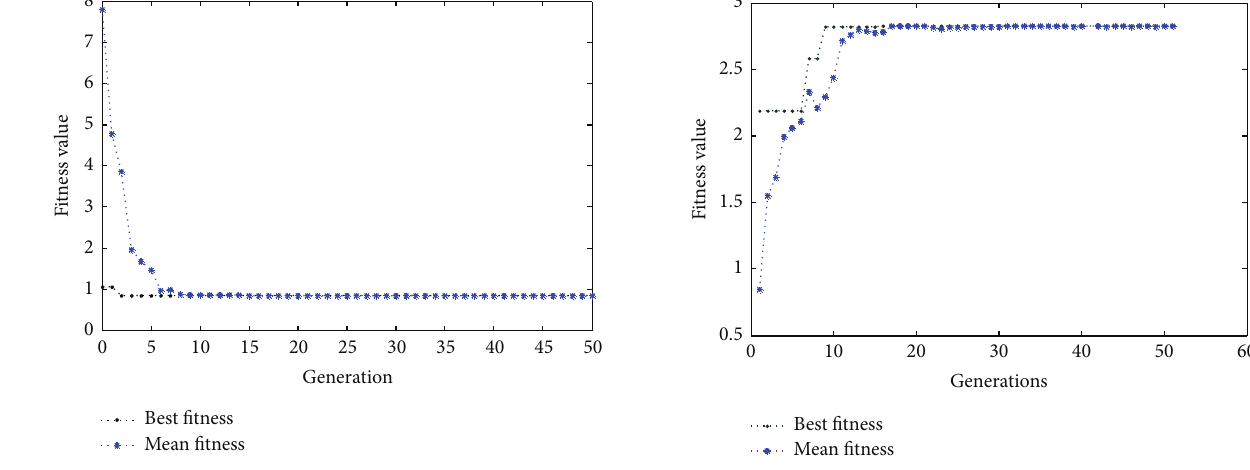
Figure 17: Fitness value considering load as objective function.